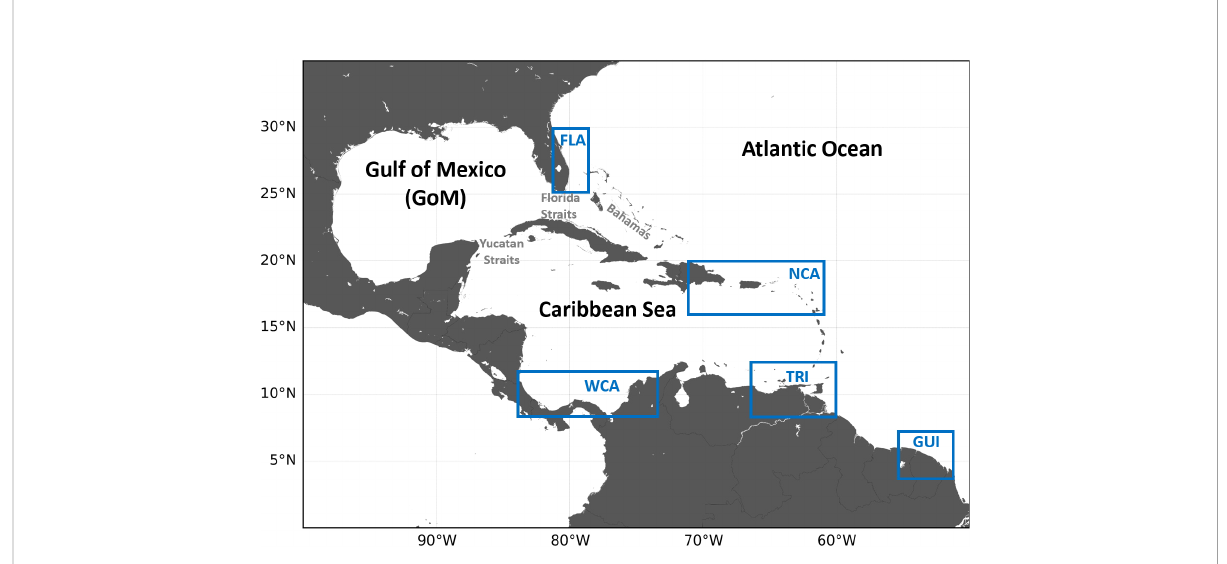
FIGURE 1 Map of the Wider Caribbean Region (WCR) showing the nesting areas (blue rectangles) of the fi ve genetic stocks of the NWA leatherback